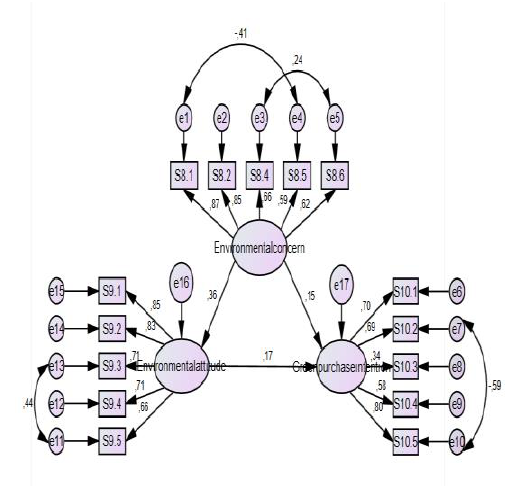
Figure 2. : The Mediating Role of Environmental Attitude on the Effect of Environmental Concern on Green Product Purchasing Intention Figure 2, results of the moderated confirmatory factor analysis adaptive scale values (CMINDF, RMSEA, GFI, CFI, RMR, NFI) show that, model is in line with data and there exists a valid and reliable scale. Table 6. The formed structural model related to the aim and hypotheses of research.